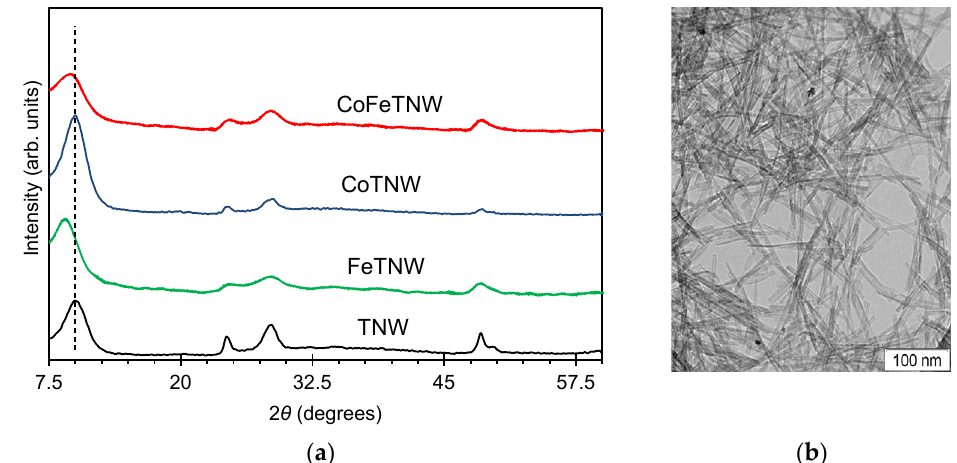
Figure 1. ( a ) XRD patterns of the TNW, FeTNW, CoTNW and CoFeTNW powders, ( b ) TEM image of a TNW sample.